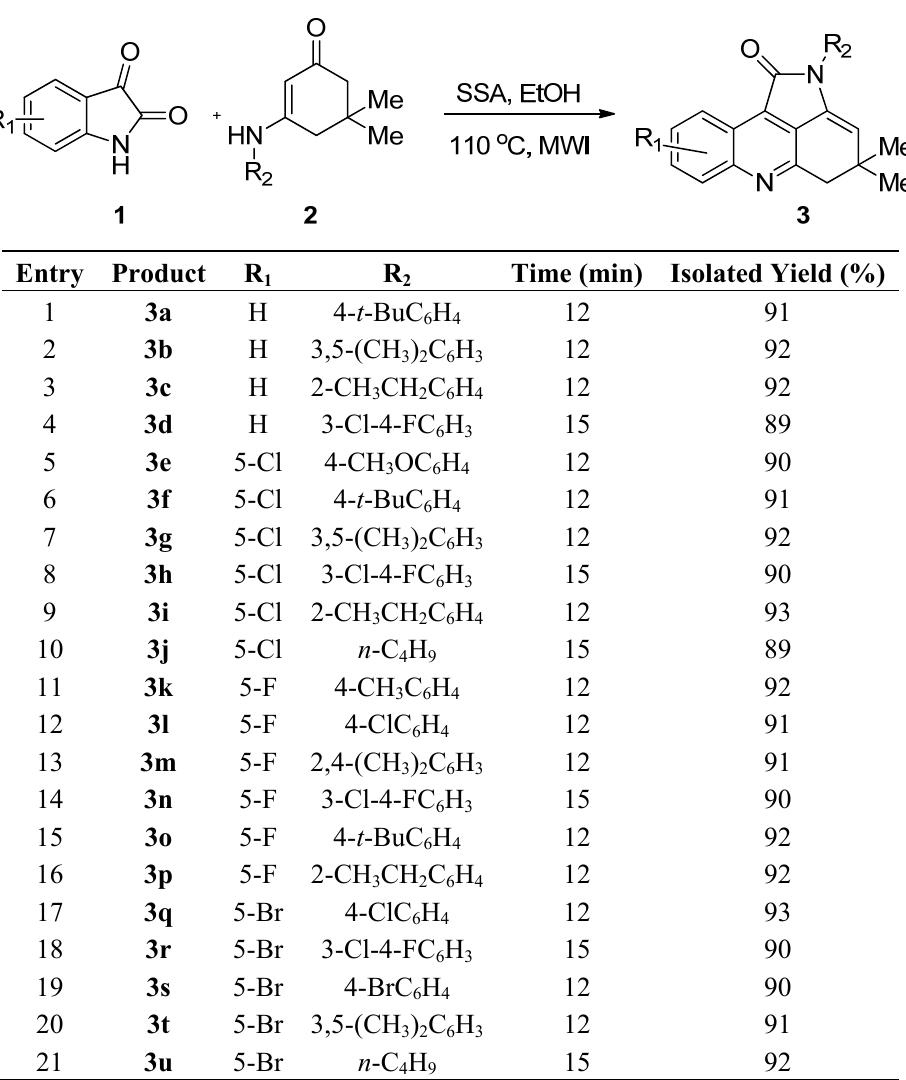
Table 2. Synthesis of dihydropyrrolo[2,3,4- kl ]acridines 3